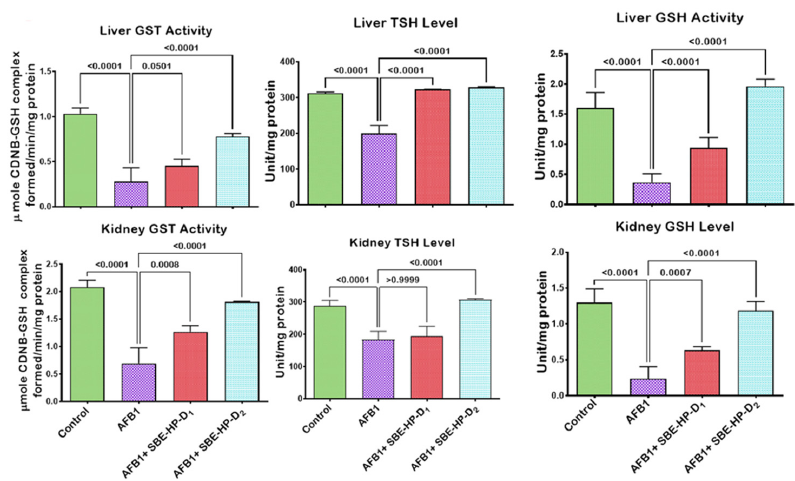
Figure 6. Effect of SBE-HP on the tissue concentrations of GST, GSH, and TSH in the liver and kidney of rats treated with AFB 1 for 28 d. AFB 1 at 50 µg/kg; SBE-HP-D1 at 5 mg/kg; SBE-HP-D2 at 10 mg/kg. Values are expressed as mean ± SD for six rats per treatment cohort. Connecting lines indicate groups compared to one another. The significance level was set at ( p < 0.05); p < 0.05 suggests the level of significance; p > 0.05: not significant. AFB 1 : Aflatoxin B1; D1: lower dose; D2: higher dose; GST: Glutathione S-transferase; GSH: reduced glutathione; TSH: Total sulfhydryl group.